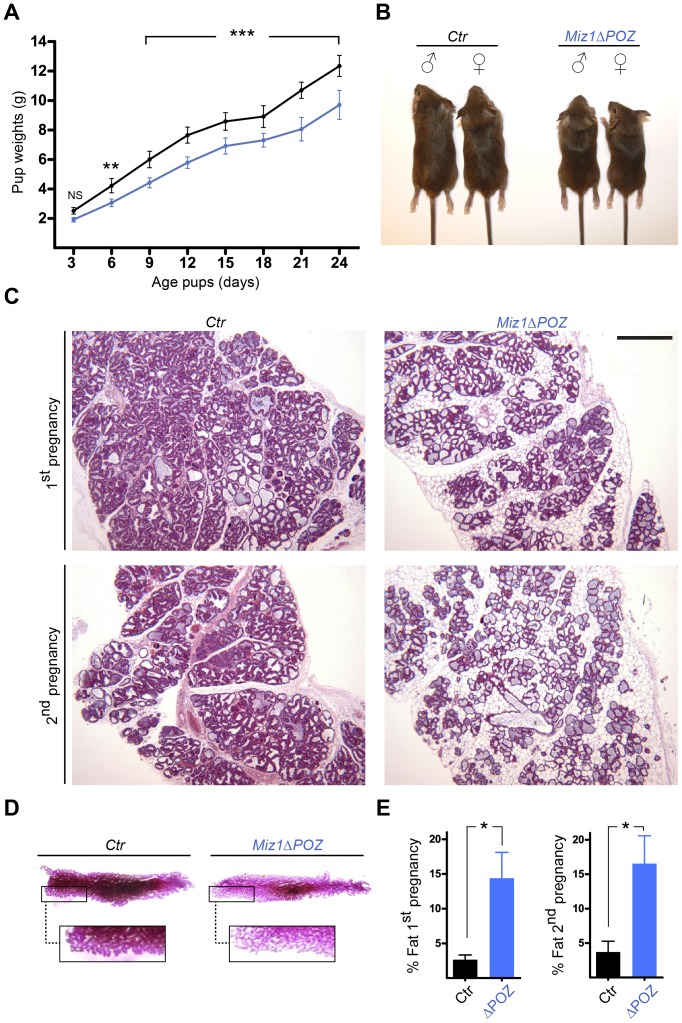
Female mice with a Miz1ΔPOZ mammary gland exhibit a lactation defect.(A) Time course of the body weight of the offspring from control (black, n = 6) and Miz1ΔPOZ mothers (blue, n = 6). The number of pups per mother was set to 6 at birth. (B) Size differences in 24-day-old pups did not depend on their gender. (C) Mammary glands from mothers of lactation day 6 were investigated by histology with H & E sections and glands from mothers of lactation day 1 were analysed in whole mounts (D). Morphometric analysis of the adipose tissue content from H & E sections (Lactation day 6) are shown in (E). Note that the difference in the ratio of glandular to adipose tissue is similar during the first and second pregnancies. Scale bar in C: 500 µm.